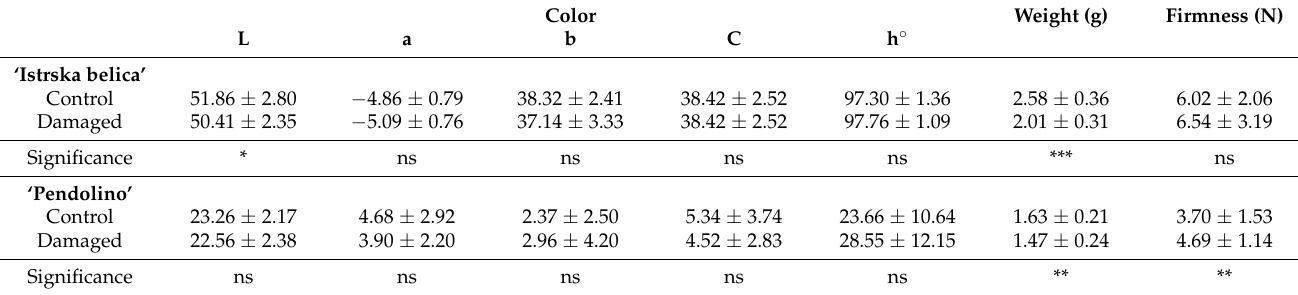
Table 1. Color, weight, and firmness of damaged and control olive fruit cv. ‘Istrska belica’ and ‘Pendolino’. Color Weight (g) Firmness (N) L b h